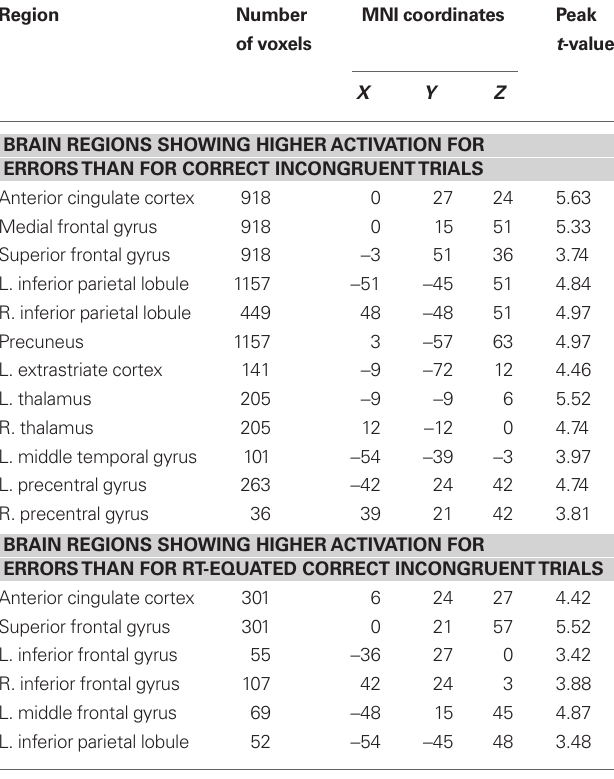
BRaIN RegIONs sHOwINg HIgHeR acTIvaTION FOR eRRORs THaN FOR cORRecT cONgRueNT TRIaLs